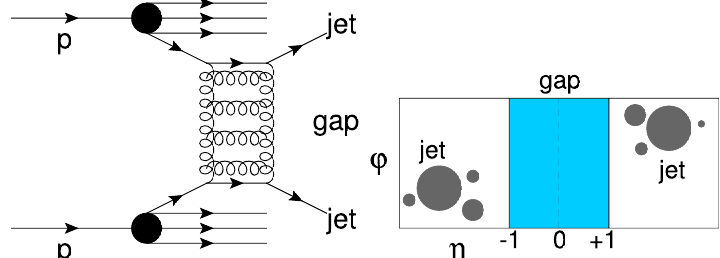
Figure 1: (Left) Schematic diagram of a jet-gap-jet event by hard color-singlet ex- change in pp collisions. (Right) Jet-gap-jet event signature in the η - φ plane. The filled circles represent final-state particles. The shaded rectangular area between the jets denotes the interval | η | < 1 devoid of charged particles. The figure is extracted from Ref. [ 1 ]